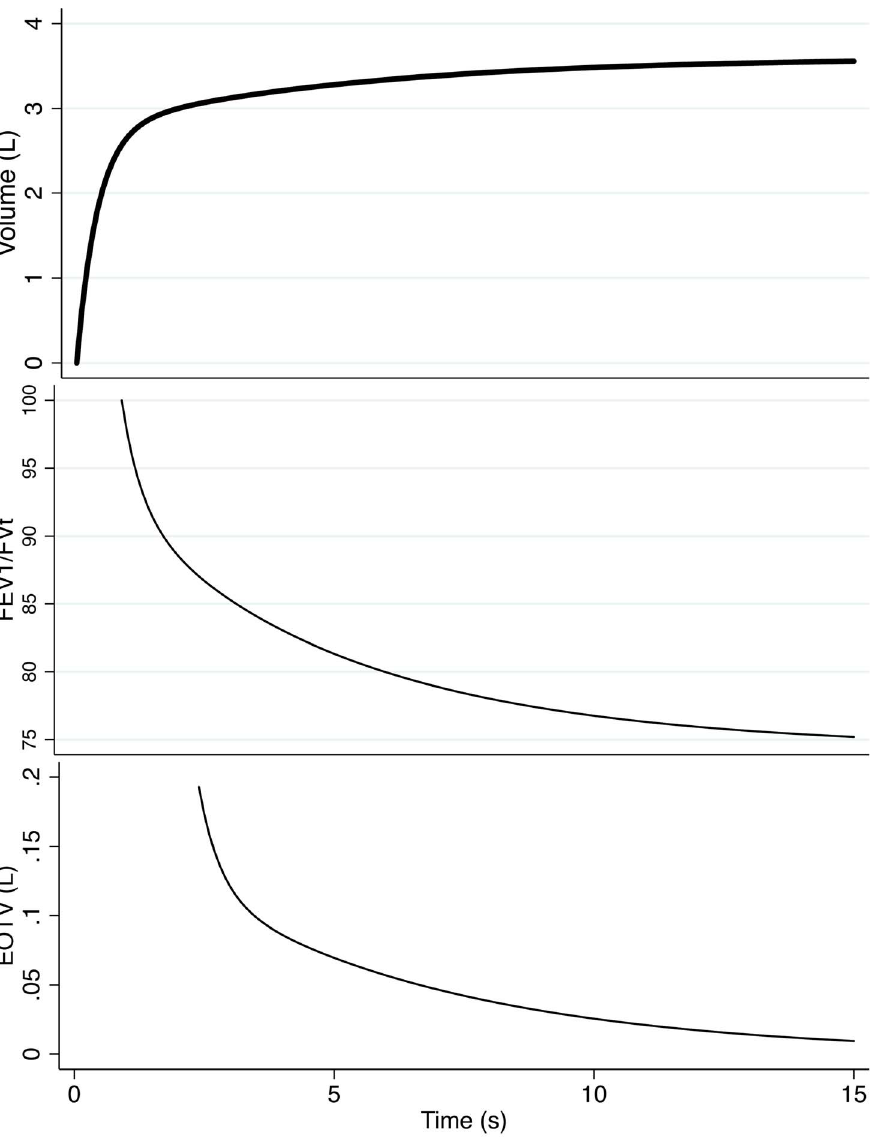
Figure 2. Volume exhaled as a function of expiratory time (upper graph), FEV 1 /FEV t (middle graph) and End-of-test volume EOTV (lower graph). The spirogram is a composite of the PLATINO baseline study based on a bi-exponential fit on individual data (see Text S1). As expiration is prolonged, EOTV decreases as well as the observed FEV 1 /FVC which increases the likelihood of diagnosing airflow obstruction by any